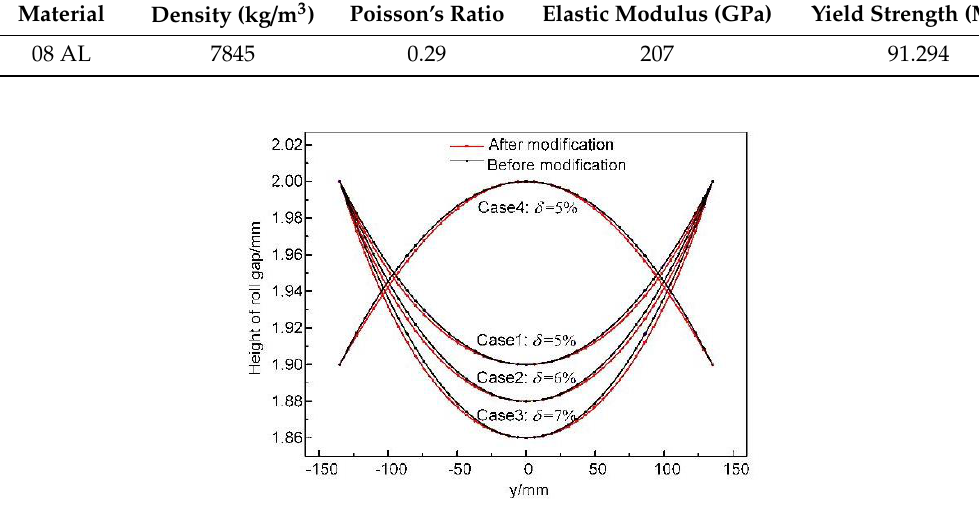
Figure 7. Height of roll gap for convex and saddle